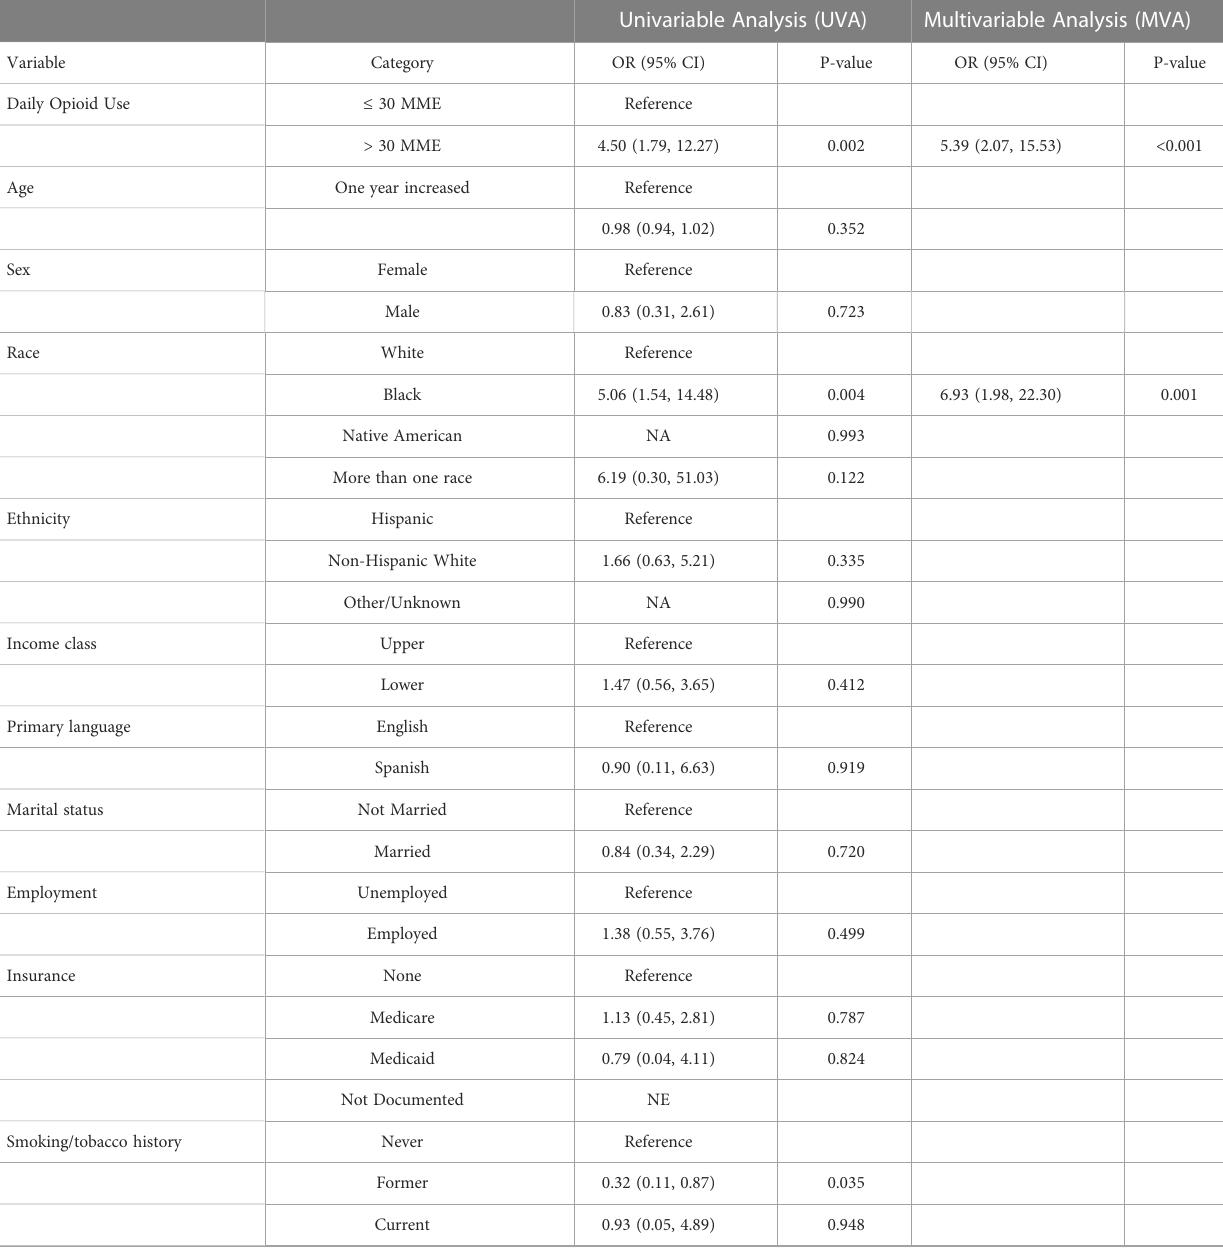
TABLE 2 Factors in fl uencing ED visits.